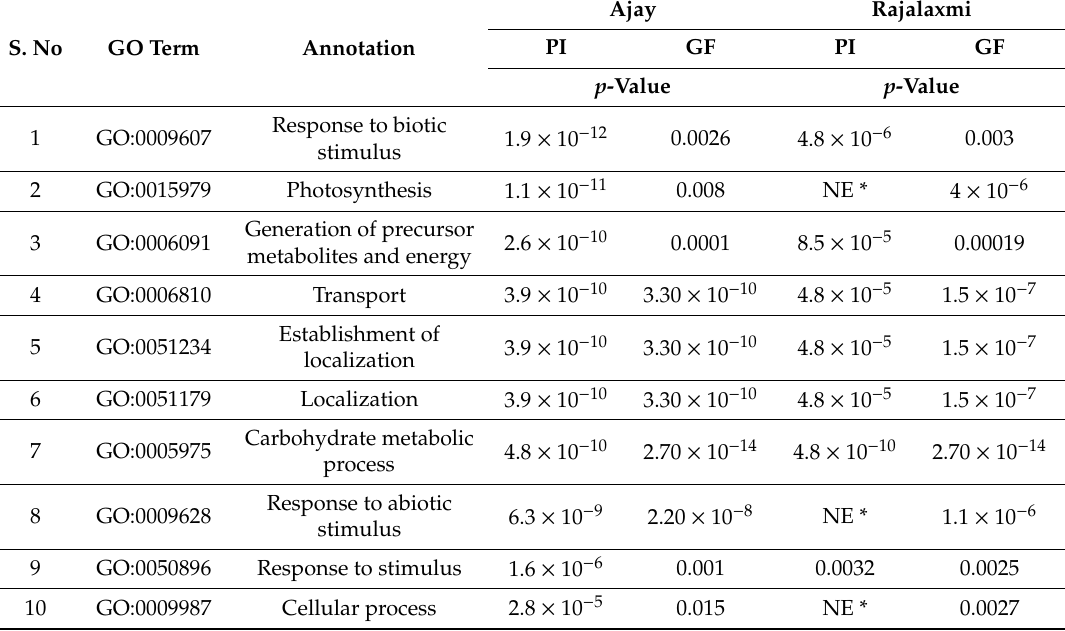
Table 4. Significant GO terms of DEGs on the basis of false discovery rate (FDR) corrected p-value of biological process in PI and GF stage in Ajay and Rajalaxmi